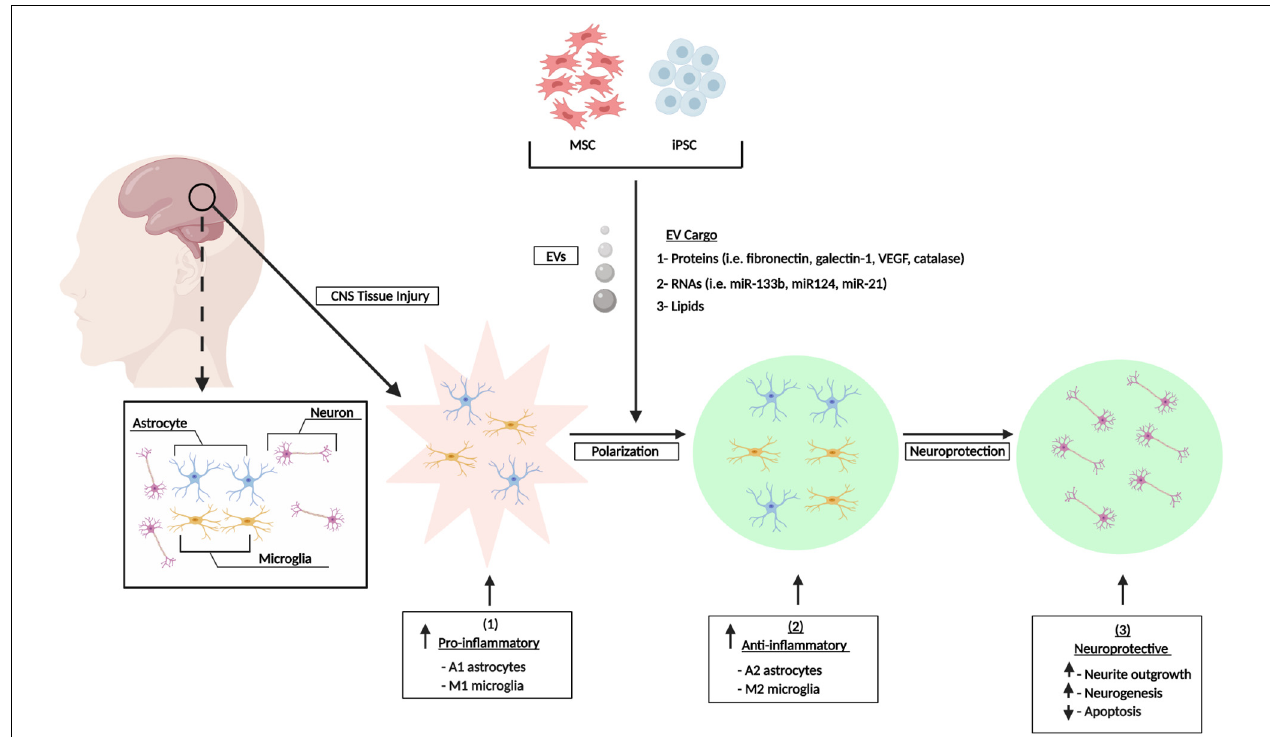
FIGURE 1 | Stem cell EV-mediated repair of CNS damage in vitro . CNS injury induces an inflammatory response characterized by increased levels of pro-inflammatory astrocytes (A1) and microglia (M1). Stem cells secrete a heterogenous population of EVs which promote the polarization of astrocytes and microglia into their A2 and M2 anti-inflammatory phenotypes, respectively. This confers an overall neuroprotective phenotype. Figure adapted from Katsuda and Ochiya (2015) and Deng M. et al. (2018).